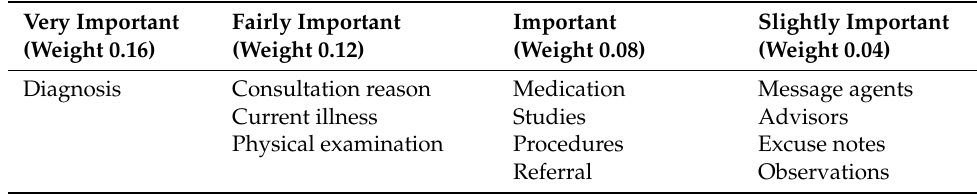
Table 2. Weight of conceptual component